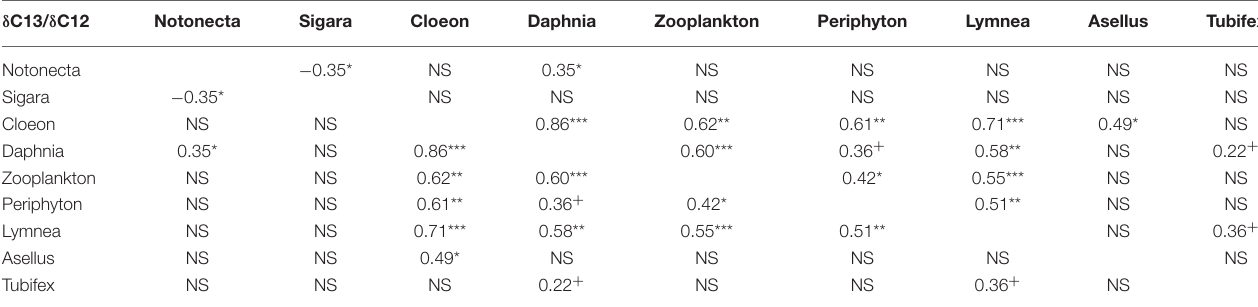
TABLE 3 | Pairwise correlation coefficients between carbon isotopes of all species in the experiment. δ C13/ δ